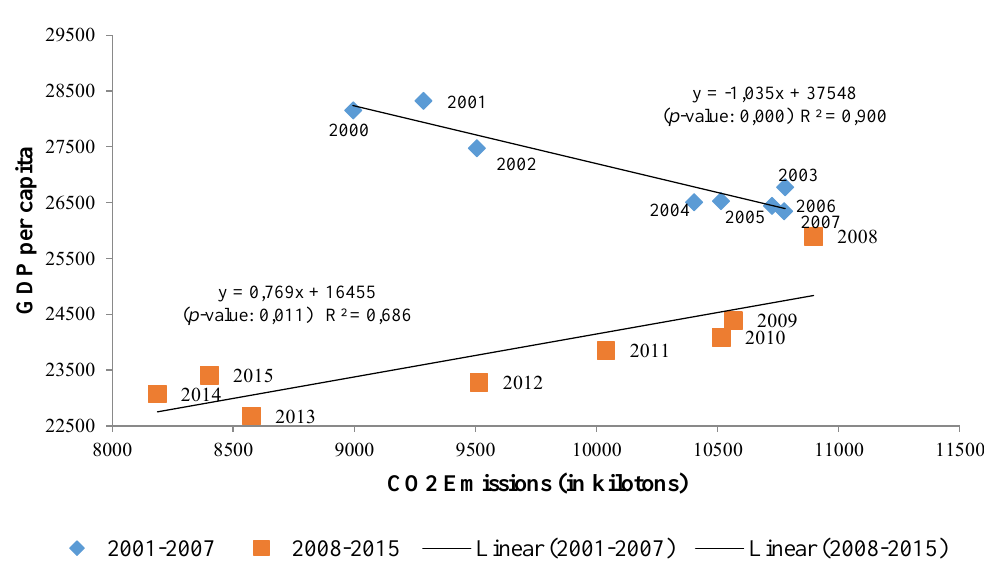
Figure 4: Linear Regression between CO2 Emissions (in kilotons) and GDP per